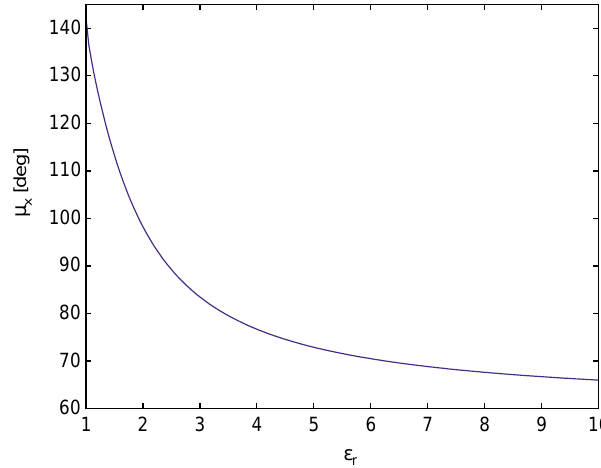
TME cell as a 2